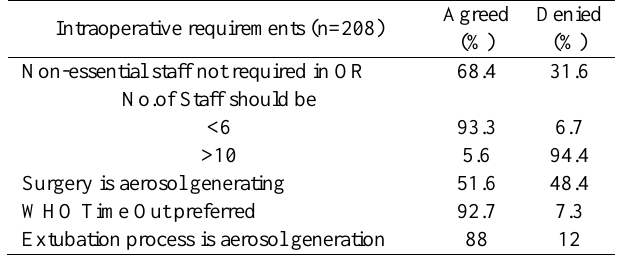
Table 3: Post-operative outcome